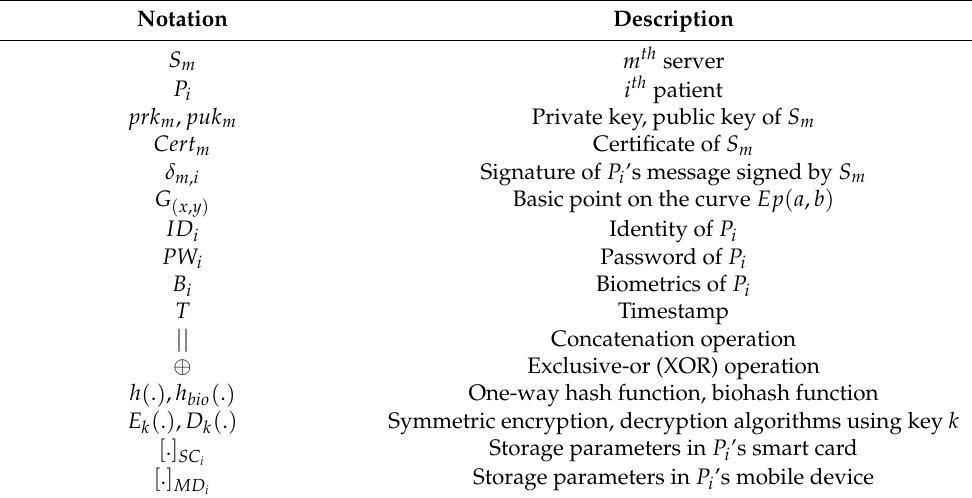
Table 1. Notations and cryptographic functions used in the